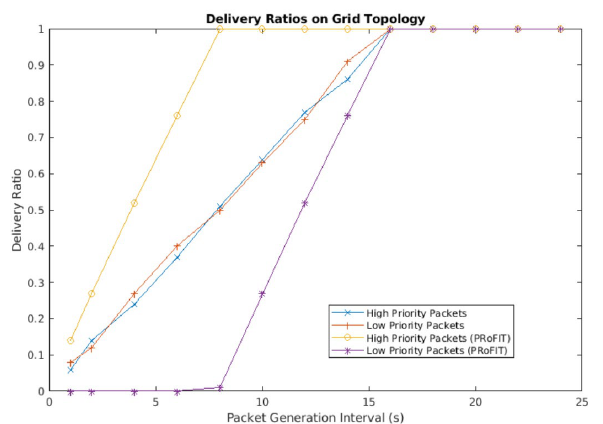
Figure 11. Delivery Ratios on Grid Topology with PRoFIT